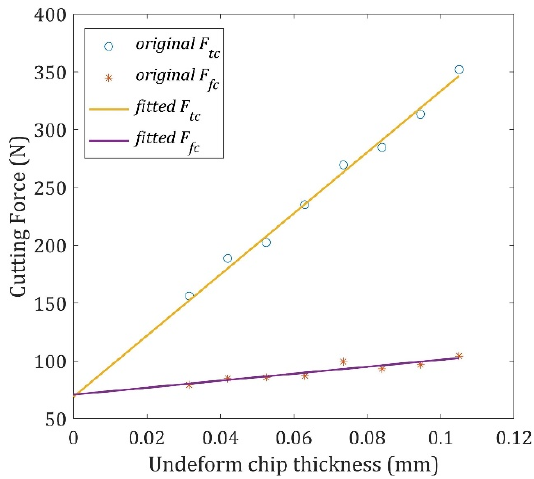
Figure 2. A number of sampled un-deformed thicknesses and corresponding cutting forces.